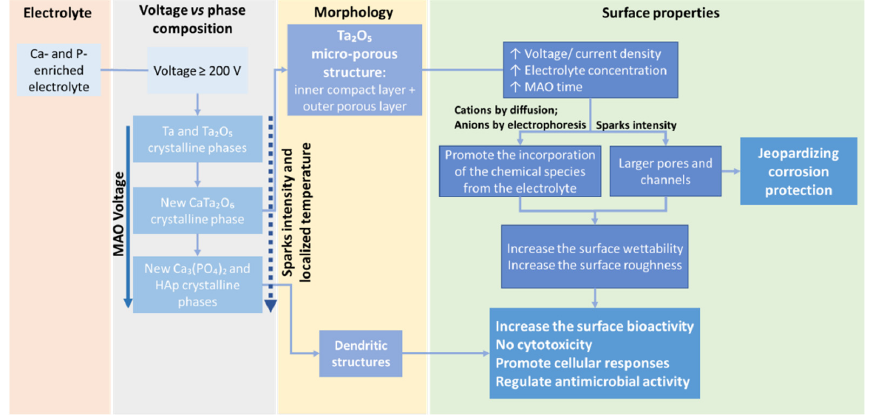
Figure 23. Surface properties of porous Ta 2 O 5 related to the MAO parameters.